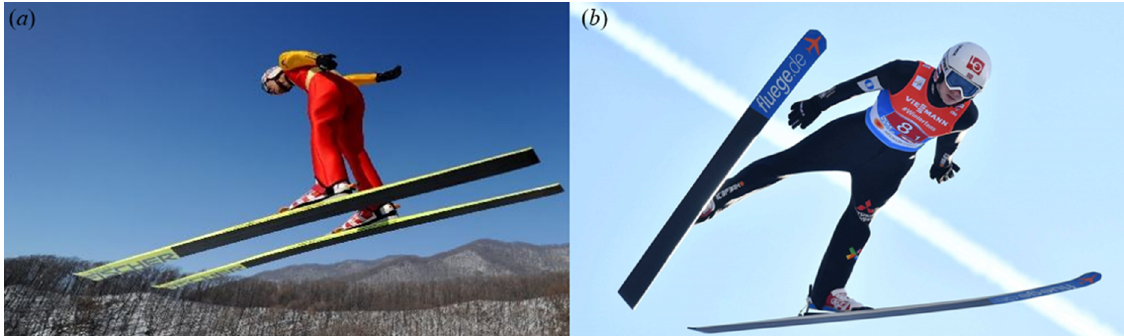
Figure 1. Two typical flight styles during the flight of ski jumping: ( a ) H-style (athlete: Guang Yang, photo: Men’s K90.3 m Ski Jumping Team Competition in the 12th National Winter Games). ( b ) V-style (athlete: Halvor Egner GRANERUD, photo: Ski Jumping World Cup).